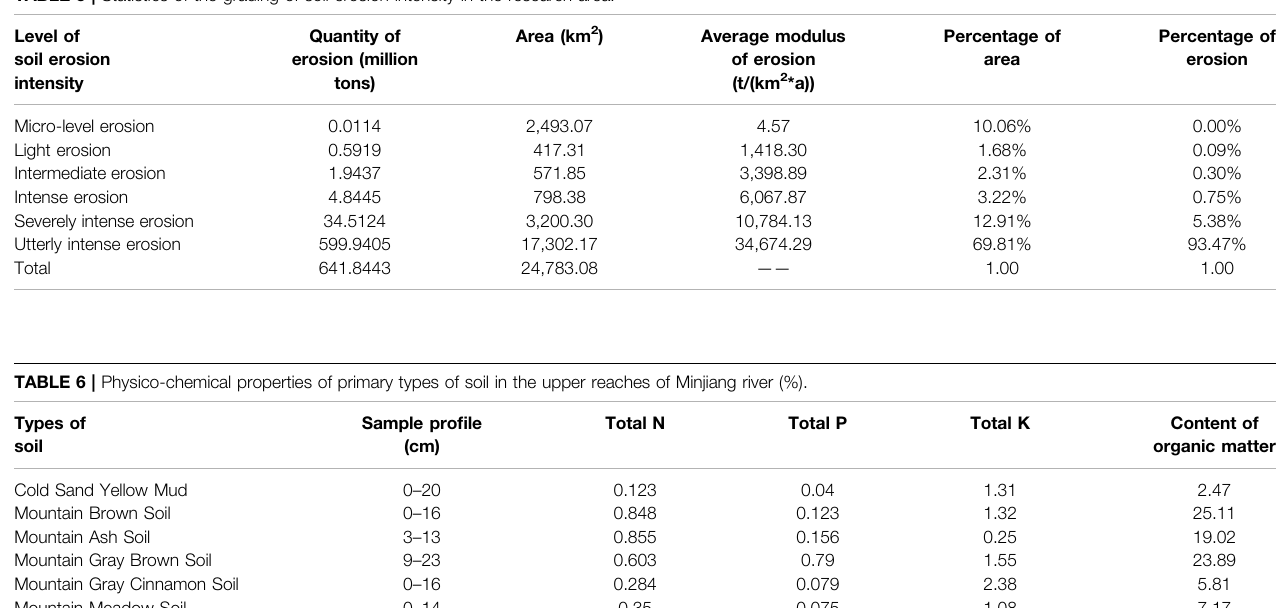
TABLE 5 | Statistics of the grading of soil erosion intensity in the research area. Level of soil erosion intensity